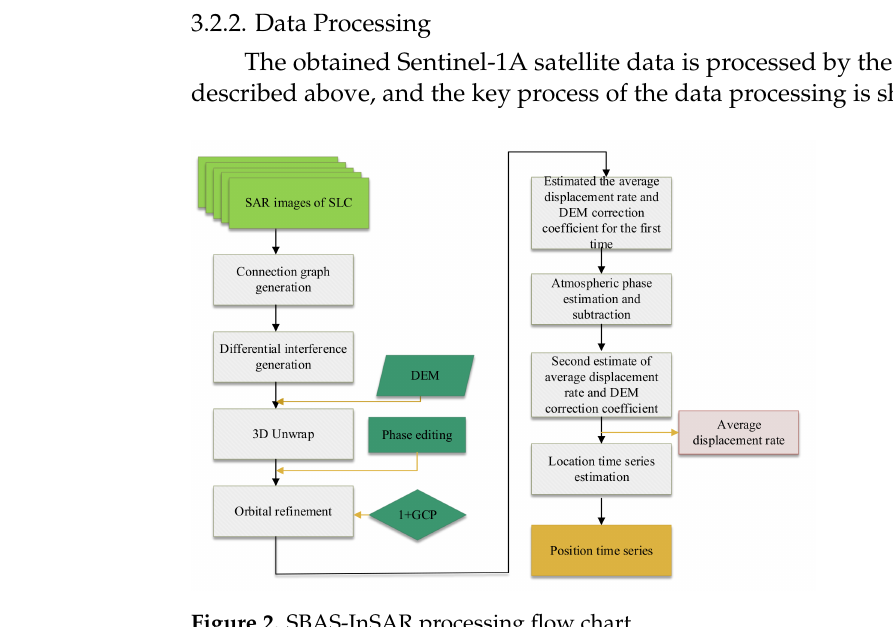
Figure 2. SBAS-InSAR processing flow